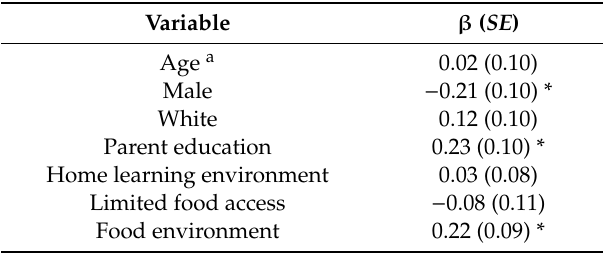
Table 3. Regression estimates predicting executive